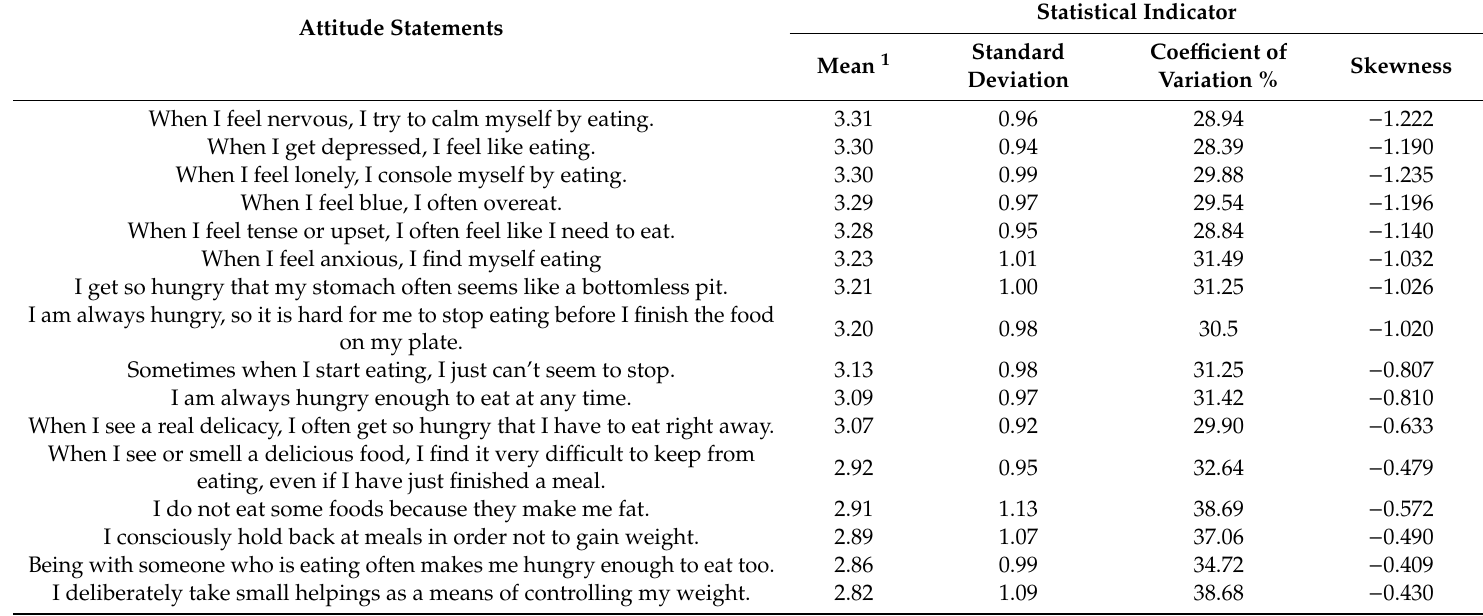
Table 2. Statistical indicators of eating attitudes ( n =